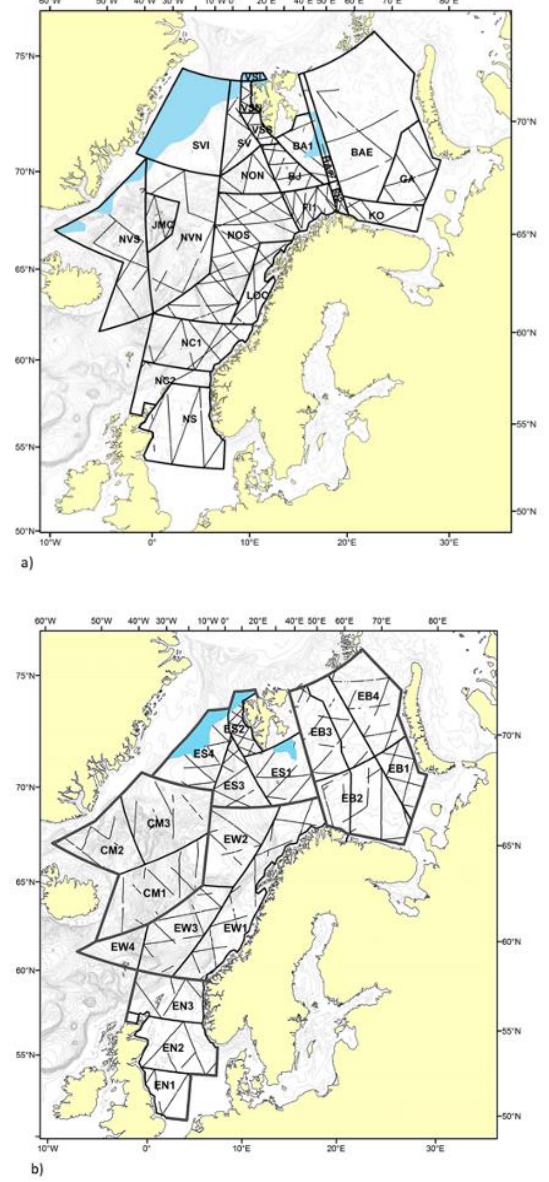
Figure 2. Survey blocks and realized search effort (Beaufort Sea State  4) on predetermined transect lines during (a) the 2002 – 2007 surveys and (b) the 2008 – 2013 surveys. The blue areas represent ice